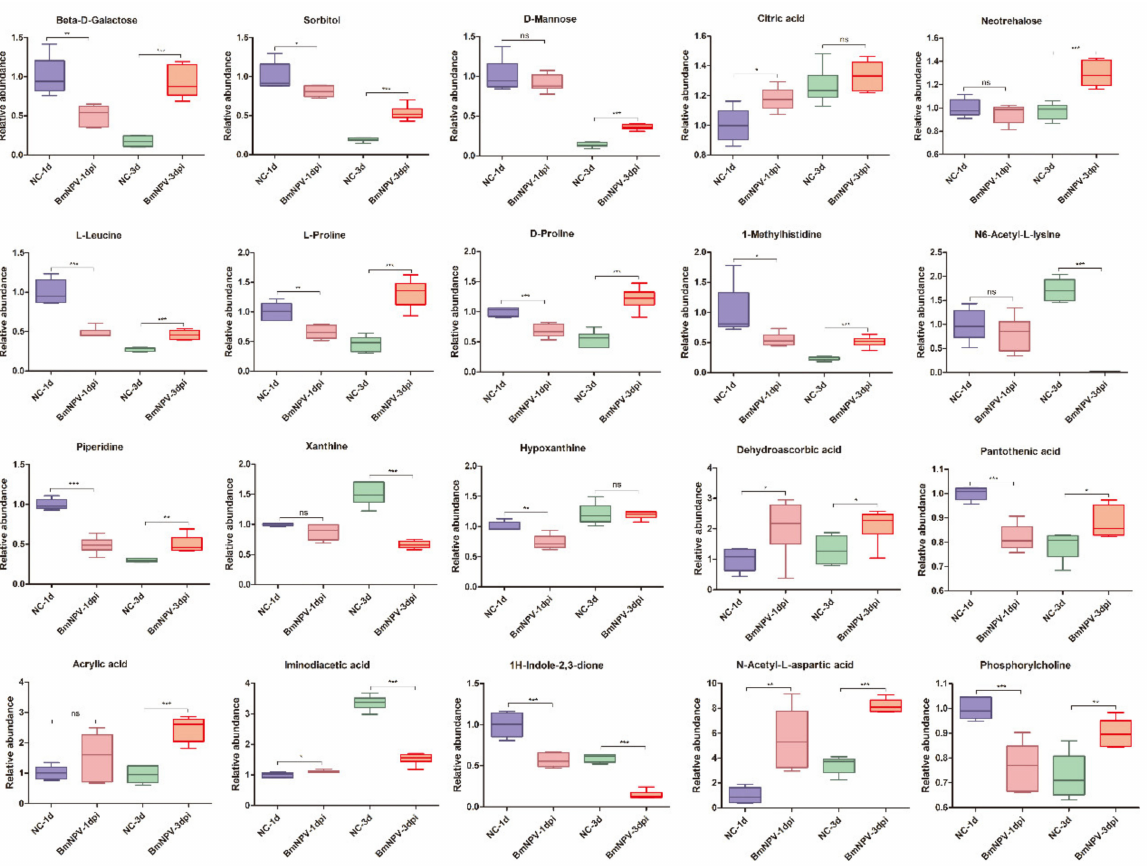
Figure 6. Abundance analysis of key metabolites that showed significant changes during BmNPV infection. The data shown are mean ± SE ( n = 5 or 6). Statistical comparisons were performed using GraphPad Prism 8 (GraphPad Software Inc., USA). Statistical significance was assessed at p values of <0.05, 0.01, or 0.001. ns p >